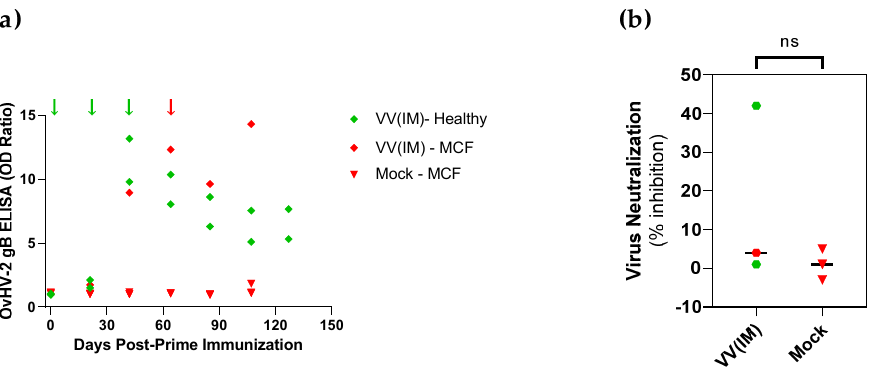
(Figure 4a). At this time point, levels of antibodies in the immunized animals increased observed ( p = 0.0220). Following the challenge, antibody titers declined and seemed to have reached a plateau around three months post-initial immunization. At 64 DPI, immediately prior to the challenge, neutralizing antibodies were observed only in one immunized rabbit, which showed a percentage of inhibition of 42% (Figure 4b).